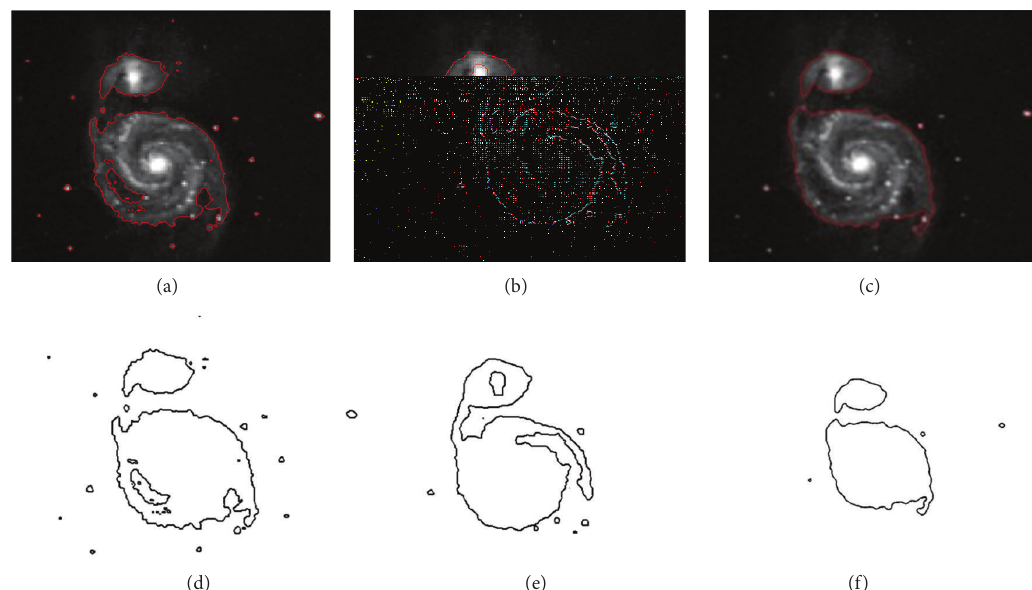
Figure 2: The segmentation results of the natural image: (a) and (d) results using CV model, (b) and (e) results using LBF model, and (c) and (f) results using the new model.